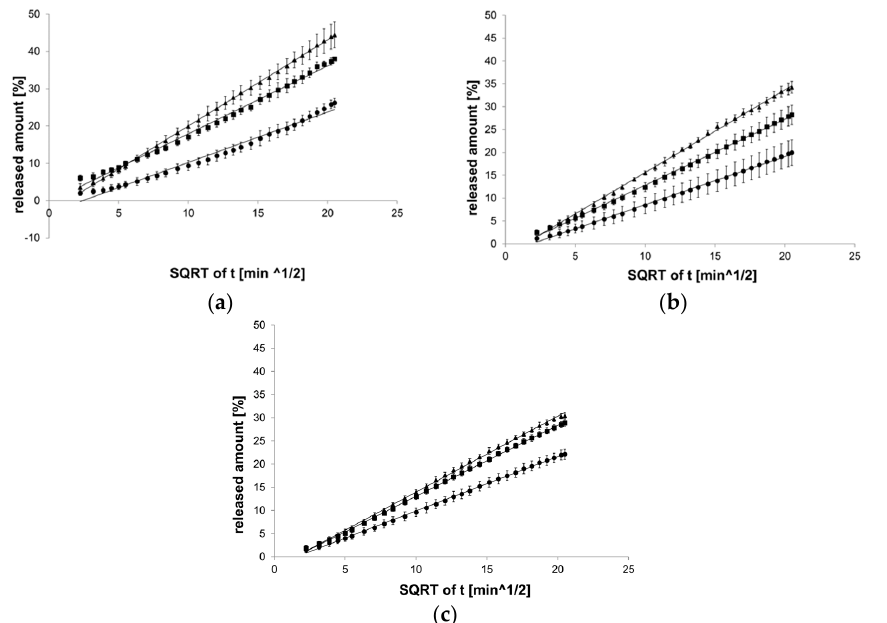
Figure 5. Process of release kinetics of β E performance according to the Higuchi model; ( a ) MC gel formulations, ( b ) PA1 gel formulations, ( c ) gel formulations with PC-11; ▲ —reference gel, ■ —20% of MSA, ● —40% of MSA, n = 6.